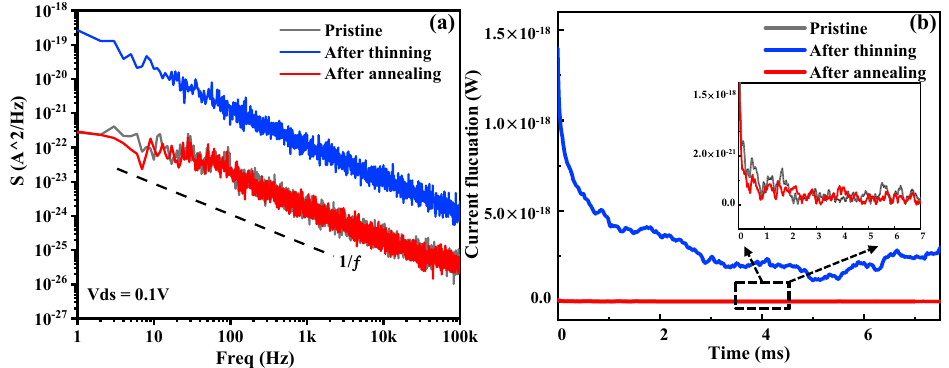
Figure 6. ( a ) Noise spectral density S(I 2 ) for the BP device under different treatments at room temperature. The source-drain bias was 0.1 V. Note that the 1/f noise increases after step 1 and decreases after step 2. ( b ) Current fluctuations in the time domain at the same current values and temperature. Inset shows the current fluctuations between the pristine (black) and the sample after annealing (red).